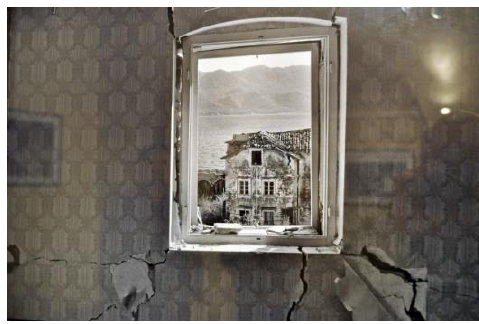
Figure 2. Openings in the walls (doors, windows) showed their vulnerability in the 1979 earthquake.